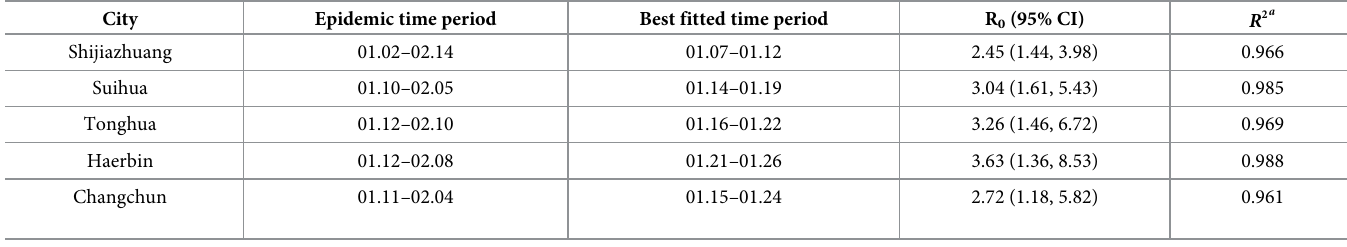
Table 2. Basic reproduction number ( R 0 ) estimated by the exponential growth